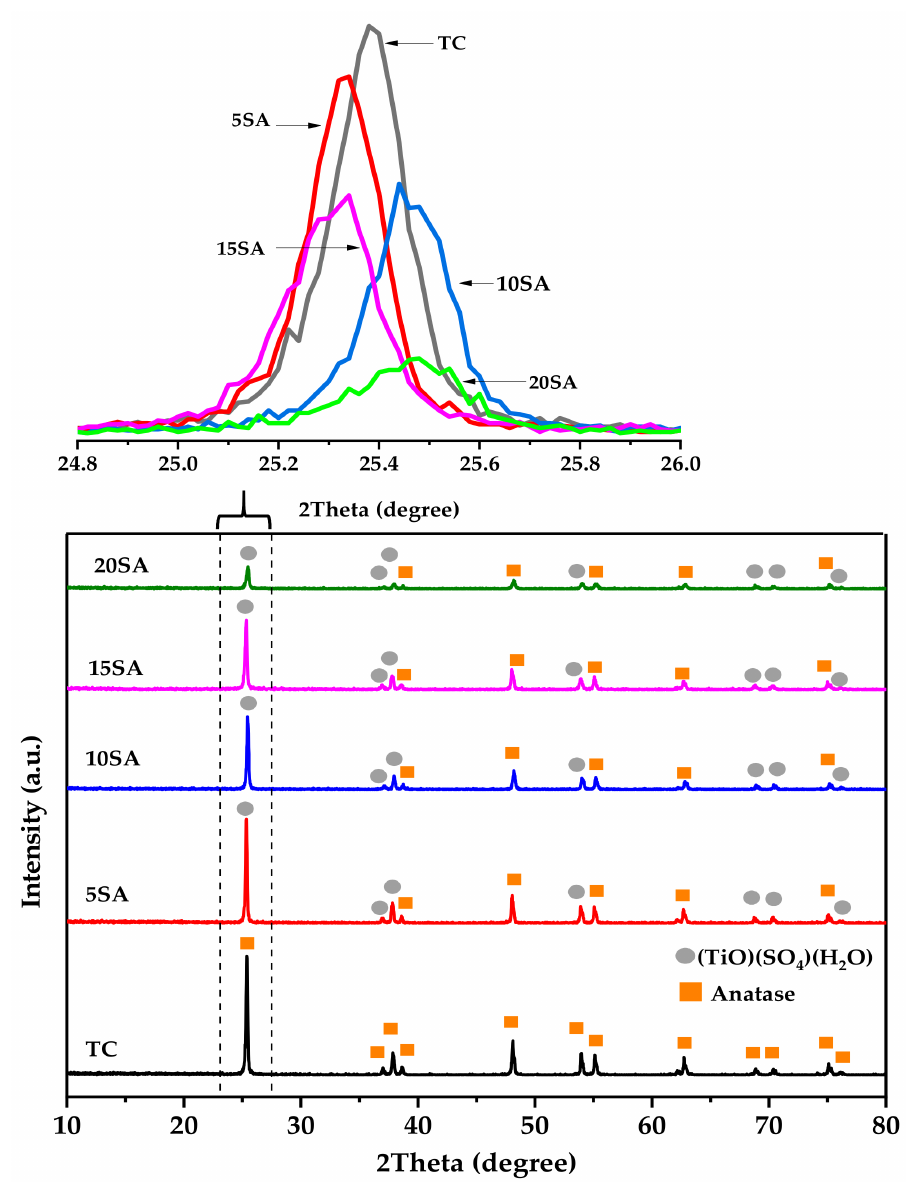
Figure 3. XRD profile of non-sulphated and sulphated-titania catalysts at various